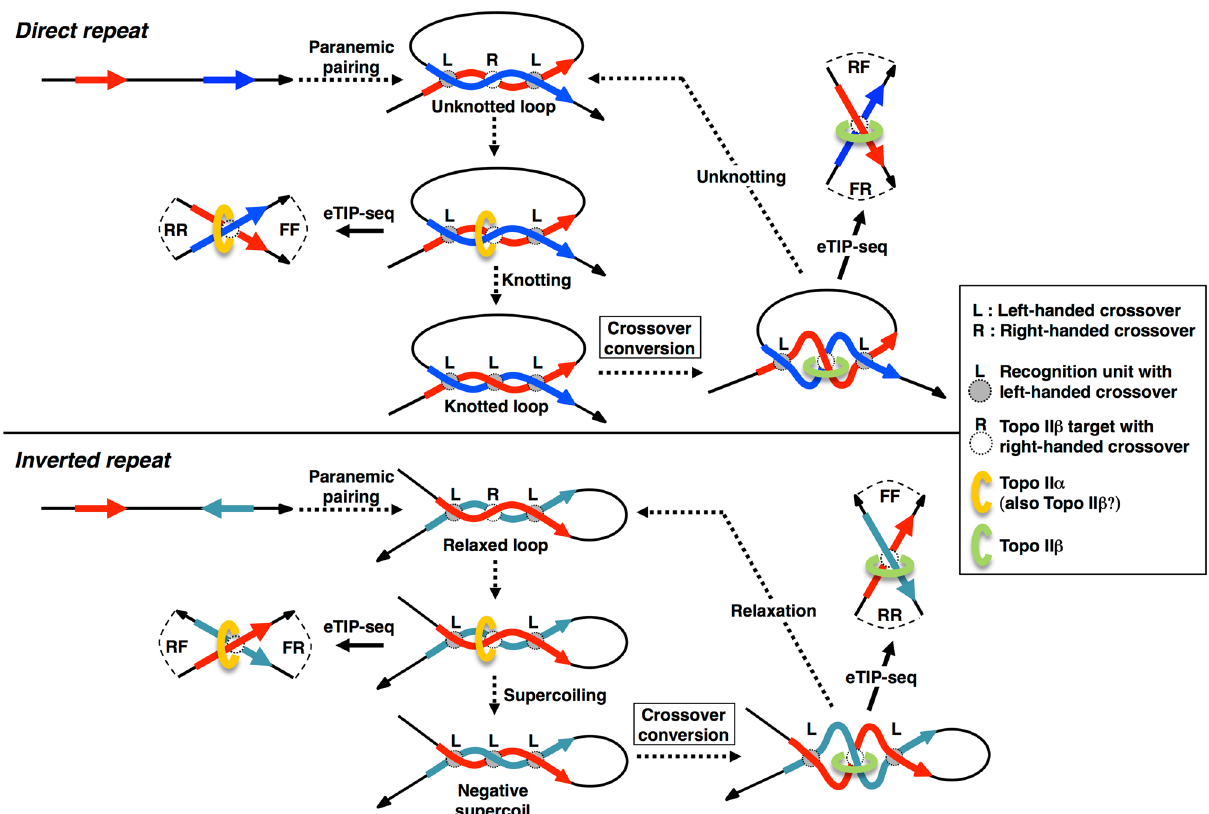
Figure 6. Homologous pairing between repetitive DNA segments at the DSP site: a model. Topo II action at these sites leads to different consequences depending on the repeat orientations, direct and inverted. Plus- strand DNA path from 5 ′ to 3 ′ direction is depicted by black arrows. Homologous segments are shown by red arrows (upstream) and blue arrows (downstream) on plus strand or by dark-green arrows on minus strand. Homologous pairing between duplex DNAs aligned in parallel starts by ‘paranemic’ mode.